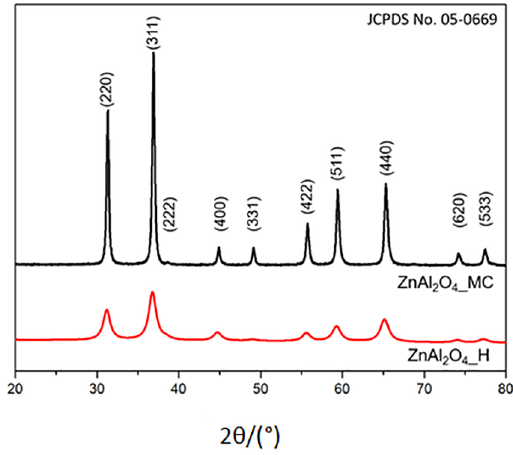
Figure 1. XRD patterns of ZnAl Table 1. Structural and textural data for ZnAl